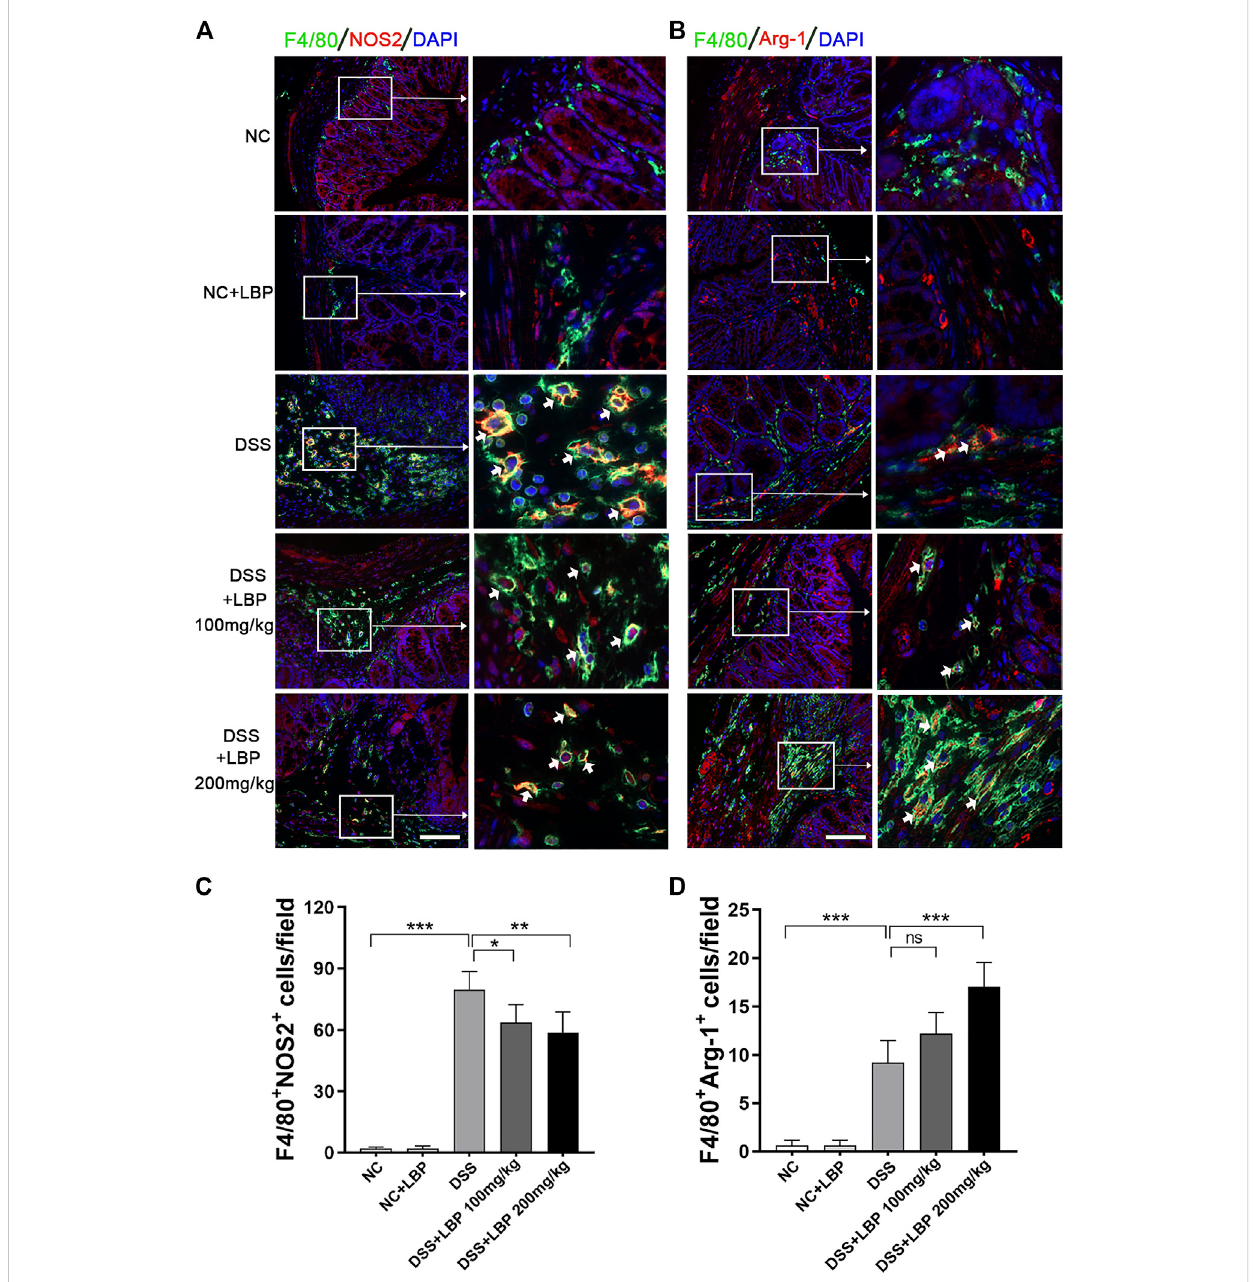
FIGURE 2 LBPtreatmentmodulatestheplasticityofintestinalmacrophages. (A) Representativeimmuno fl uorescenceimagesofF4/80(greencolor)andNOS2 (red color) in colon tissues from fi ve groups of mice, and cell nucleus were stained with DAPI (blue). The right panel is the inset image from the corresponding region from the left panel. (B) Representative immuno fl uorescence images of F4/80 (green color) and Arg-1 (red color) in colon tissues from fi ve groups of mice, and cell nucleus were stained with DAPI (blue). The right panel is the inset image from the corresponding region from the left panel. (C) The number of F4/80 + NOS2 + cells in Figure 2A were quanti fi ed. (D) The number of F4/80 + Arg-1 + cells in Figure 2B were quanti fi ed. Scale bar, 100 µm. Signi fi cant differences are indicated as * p < 0.05, ** p < 0.01; *** p < 0.001. Ns, no signi fi